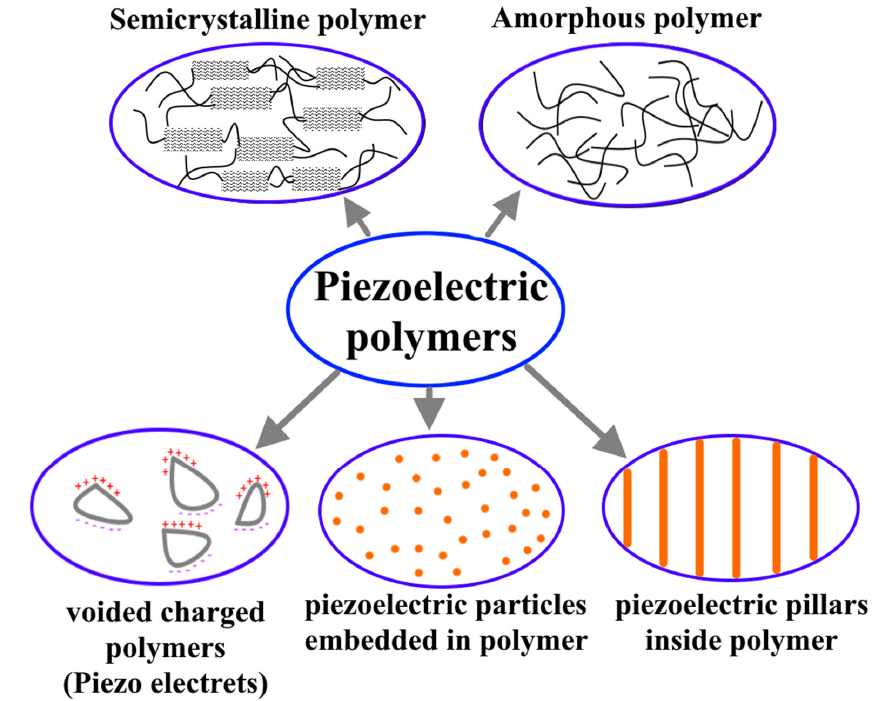
Figure 9. Piezoelectric polymers classification.